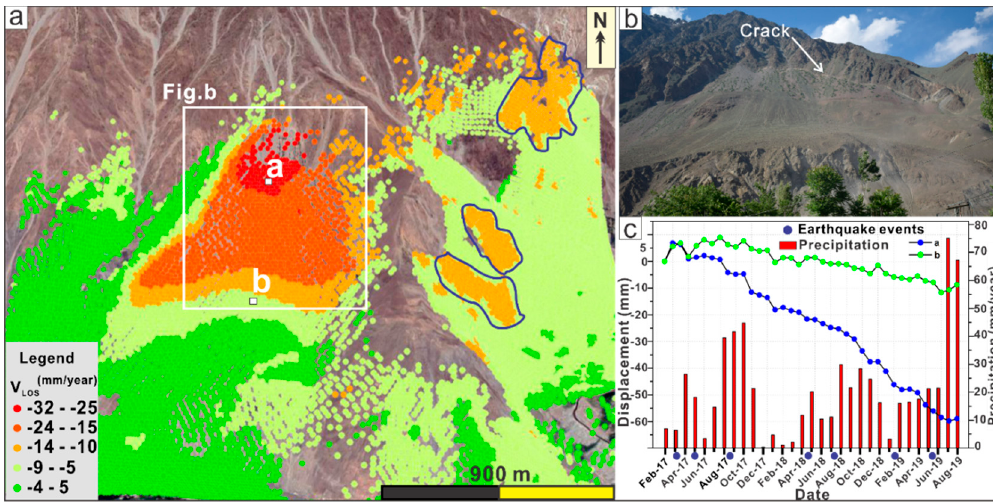
Figure 8. Ghulmet landslide. ( a ) The LOS displacement rates in the Ghulmet landslide as superimposed on Google Earth map for perspective view; ( b ) field picture of Ghulmet landslide, and ( c ) displacement time series for representative pixels, for point a and b. Khai Landslide